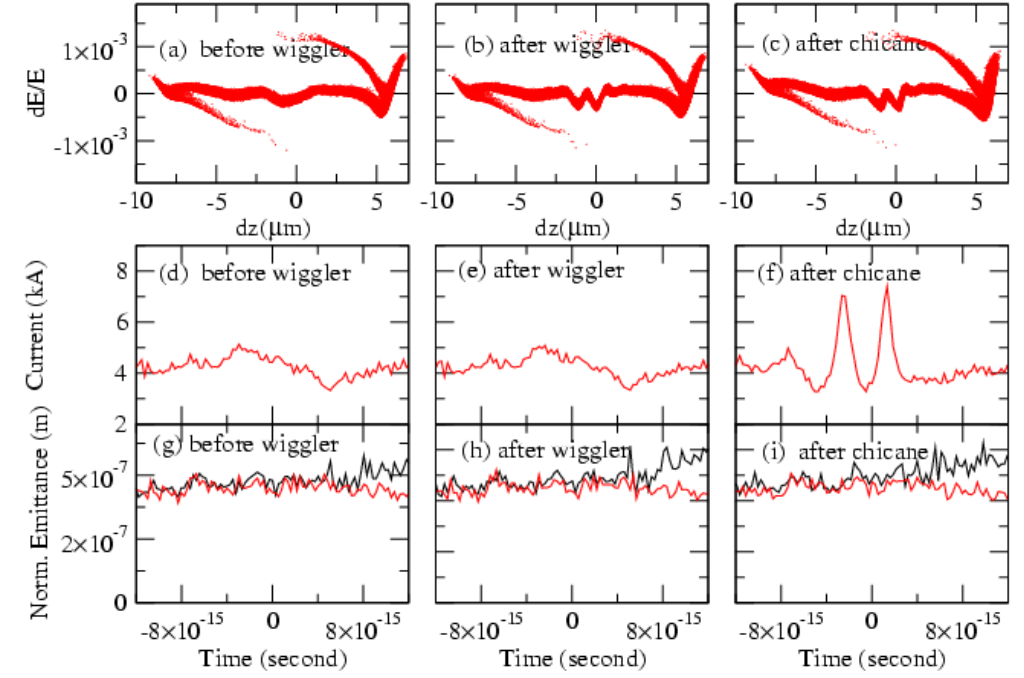
Figure 9. ( Color online). The change of the characteristics of the 4 kA, 16 μm-long electron bunch. ( a )–( c ): the longitudinal energy distribution. ( d )–( f ): current profile. ( g )–( i ): horizontal (black line) and transverse normalized-emittance (red line) [42].